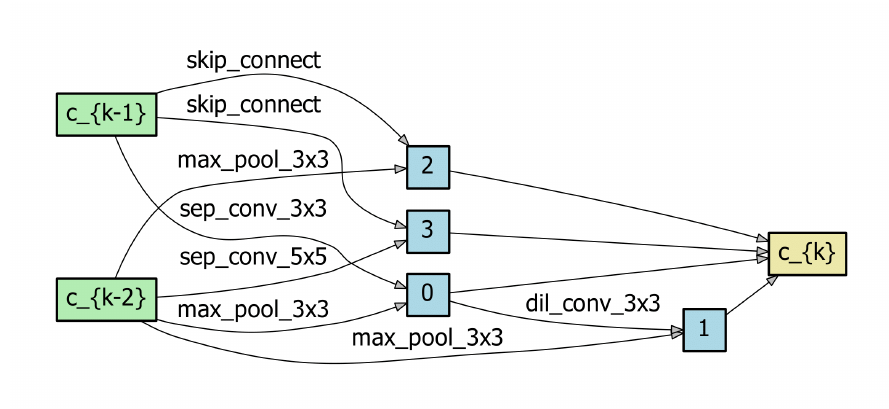
Figure 7. Architecture found by DG-DART on the CIFAR10 data set. ( a ) Normal cell. ( b ) Reduc- tion